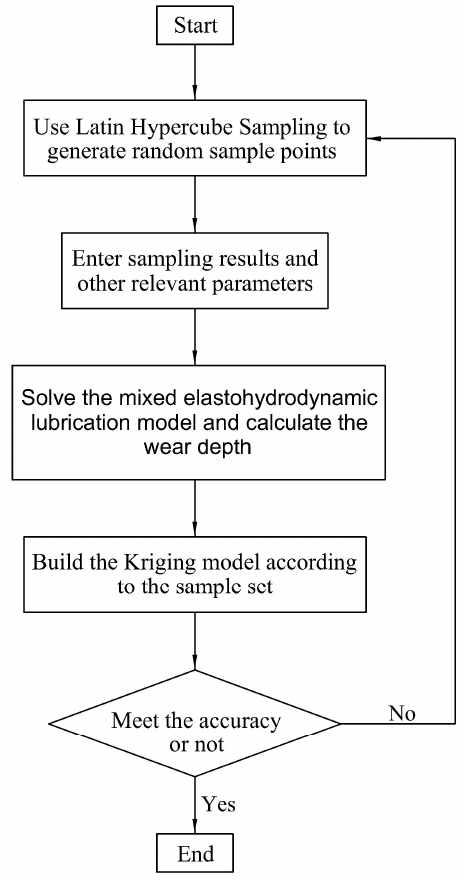
Figure 3. Flowchart for building the Kriging model.